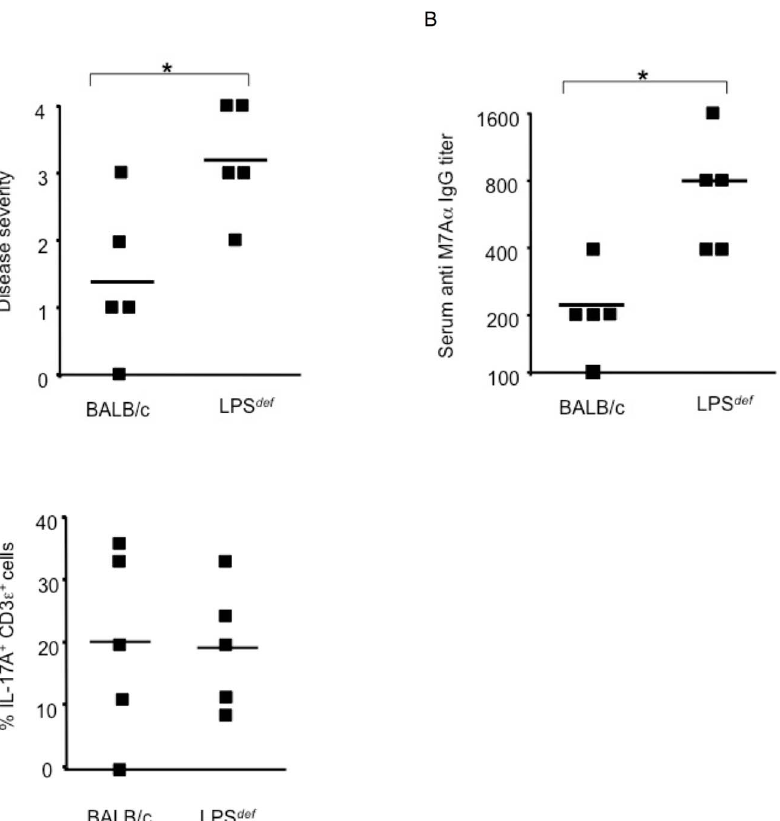
Figure 1. LPS def mice are highly susceptible to induction of autoimmune inflammatory heart disease. Genetic loss of TLR4 function leads to severe autoimmune myocarditis in mice challenged with heart-specific autoantigen and complete Freund’s adjuvant (CFA), a complex mixture of TLR agonists. (A) LPS def. mice lacking functional TLR4 developed significantly more severe autoimmune myocarditis that wild type BALB/c control mice. Histopathological disease severity, as described in Methods, was determined 21 days after the initial immunization with heart-specific M7A a peptide and CFA. * p , 0.05. One representative result out of 5 independent experiments is shown. (B) Serum IgG autoantibodies reactive to heart specific epitope M7A a were determined 21 days after initial immunization with heart-specific M7A a peptide and CFA. * p , 0.05. One representative result out of 5 independent experiments is shown. (C) Heart inflammatory infiltrate. CD3 e + T cells expressing IL-17A were evaluated 21 days after initial immunization with heart-specific M7A a peptide and CFA. Squares represent the percentage of IL-17A + cells per CD3 e + T cells as determined by immunohistochemistry in heart-sections from individual mice, lines indicate mean values. * p , 0.05. One representative result out of 5 independent experiments is shown. (D) Representative photomicrograph of heart section from a LPS def mouse immunized with autoantigen and CFA. Inflammatory infiltrate consisting mostly of mononuclear cells is present throughout the myocardium often surrounding necrotic cardiomyocytes (arrow). Original magnifications x10 and x200 are shown. Hearts were analyzed 21 days after initial immunization with heart-specific M7A a peptide in CFA. Staining was with hematoxylin and eosin (H&E). (E) Histopatholgy in a heart section from a BALB/c mouse immunized with heart-specific M7A a peptide in CFA. Inflammatory infiltrate consisting mostly of mononuclear cells is present as an inflammatory focus (arrow). Original magnifications x100 is shown. (F) LPS def. mice fail to resolve autoimmune myocarditis by day 28 after the initial autoantigen challenge but not wild type BALB/c control mice. Histopathological disease severity, as described in Methods, was determined 28 days after the initial immunization with heart-specific M7A a peptide and CFA. * p , 0.05. Squares represent individual mice, lines indicate mean values. One representative result out of 3 independent experiments is shown. Student’s t Test was used for statistical